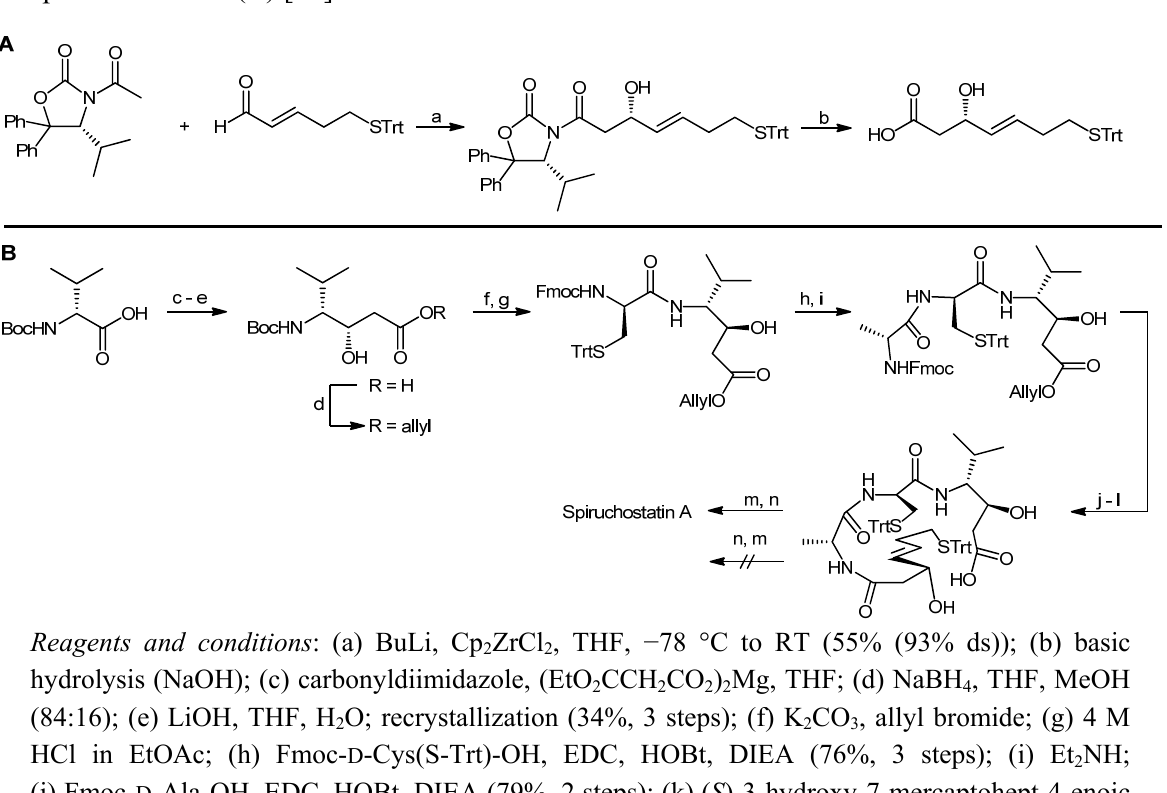
Scheme 8. Synthesis of a mercaptoheptenoic acid building block ( A ) and assembly of spiruchostatin A ( B )